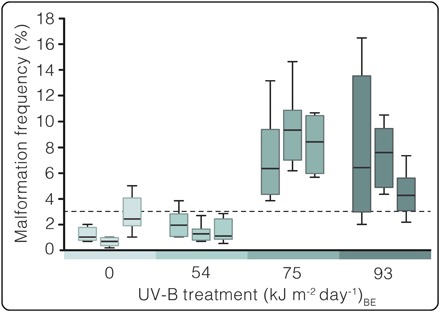
UV-B impacts on malformed pollen production in pines (P. mugo).Boxplots representing malformation frequencies of individual trees in control and three modeled end-Permian UV-B regimes. Y axis: Malformation frequency: Percent malformed grains (n = 600 grains per cone, eight cones per tree, three trees per treatment). X axis: UV-B treatment (kJ m−2 day−1)BE: Treatments correspond to growth chamber control (0) and end-Permian modeled (54, 75, and 93) UV-B regimes. The dashed line indicates 3% malformation frequency of stressed trees in nature (5). See results in table S1 and summary in table S2 for two–mixed-factor nested ANOVA.